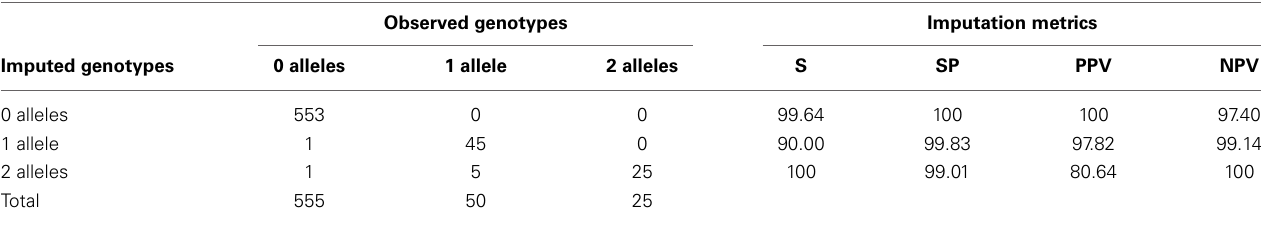
Table 7 | Concordance between imputed and observed genotypes according to the number of defective alleles and characteristics of the imputation in terms of sensitivity (S), specificity (SP), positive predictive value (PPV) and negative predictive value (NPV) ( N =